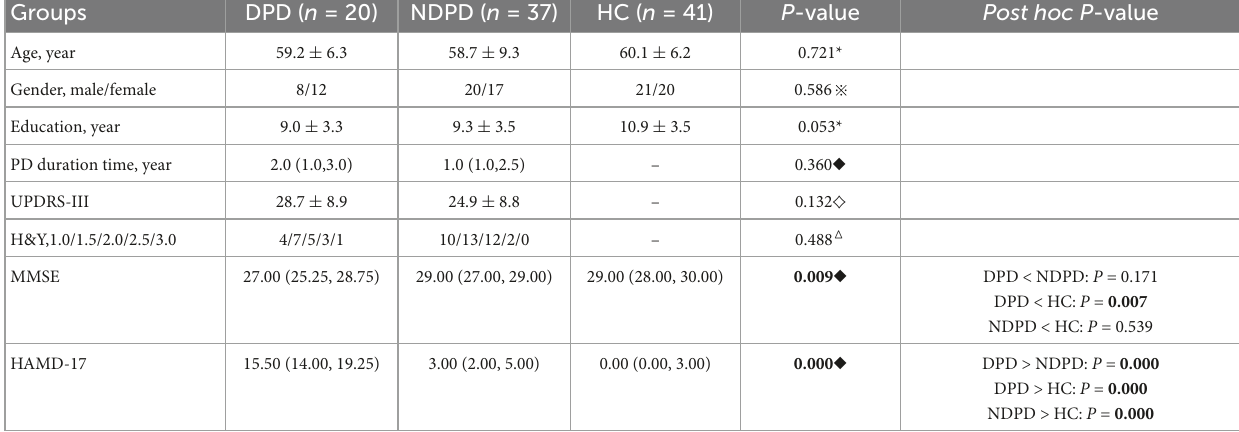
TABLE 1 Demographic and clinical characteristics of three groups, including DPD, NDPD, and HC. Groups